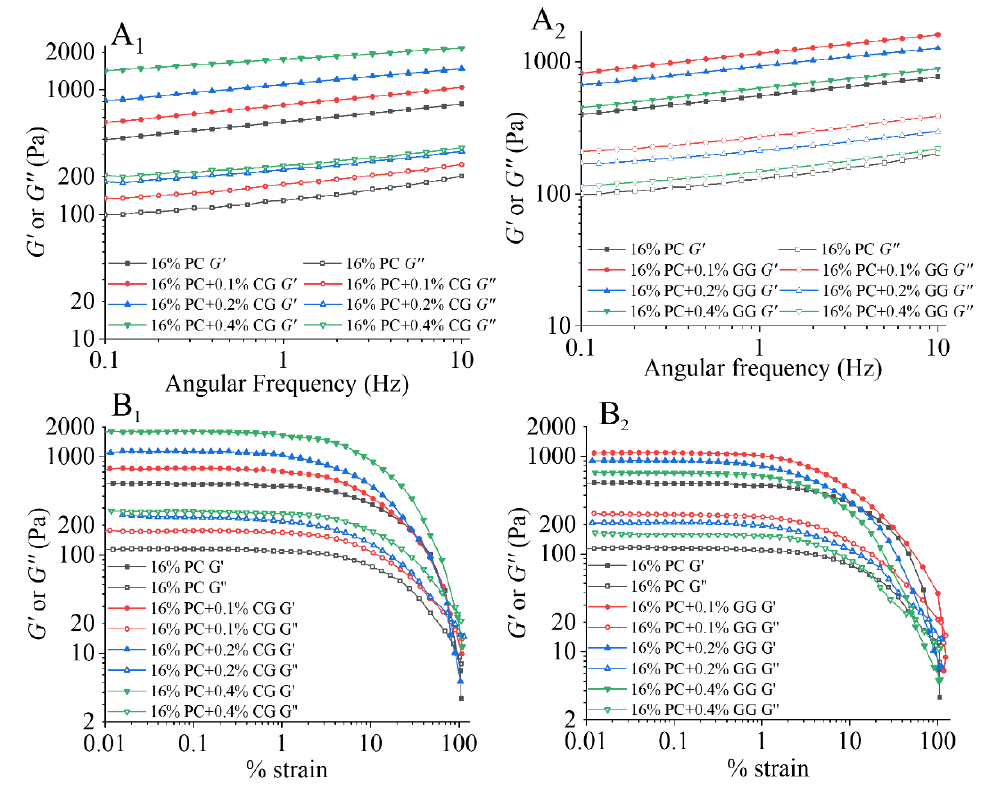
Figure 1. The storage and loss modulus ( G' and G" ) values as increasing of the angular frequency of the PC-CG ( A 1 ) and PC-GG ( A 2 ) gels at various polysaccharide concentrations (CG or GG, 0%-0.4%). The storage and loss modulus ( G' and G" ) values as increasing of the strain of the PC-CG ( B 1 ) and PC-GG ( B 2 ) gels at various polysaccharide concentrations. In order to further evaluate th e gels’ strength, the frequency ( ω ) dependence of G' and G" of the gels was fitted by the Power-law model. The fitted data are shown in Table 1. For all samples, the